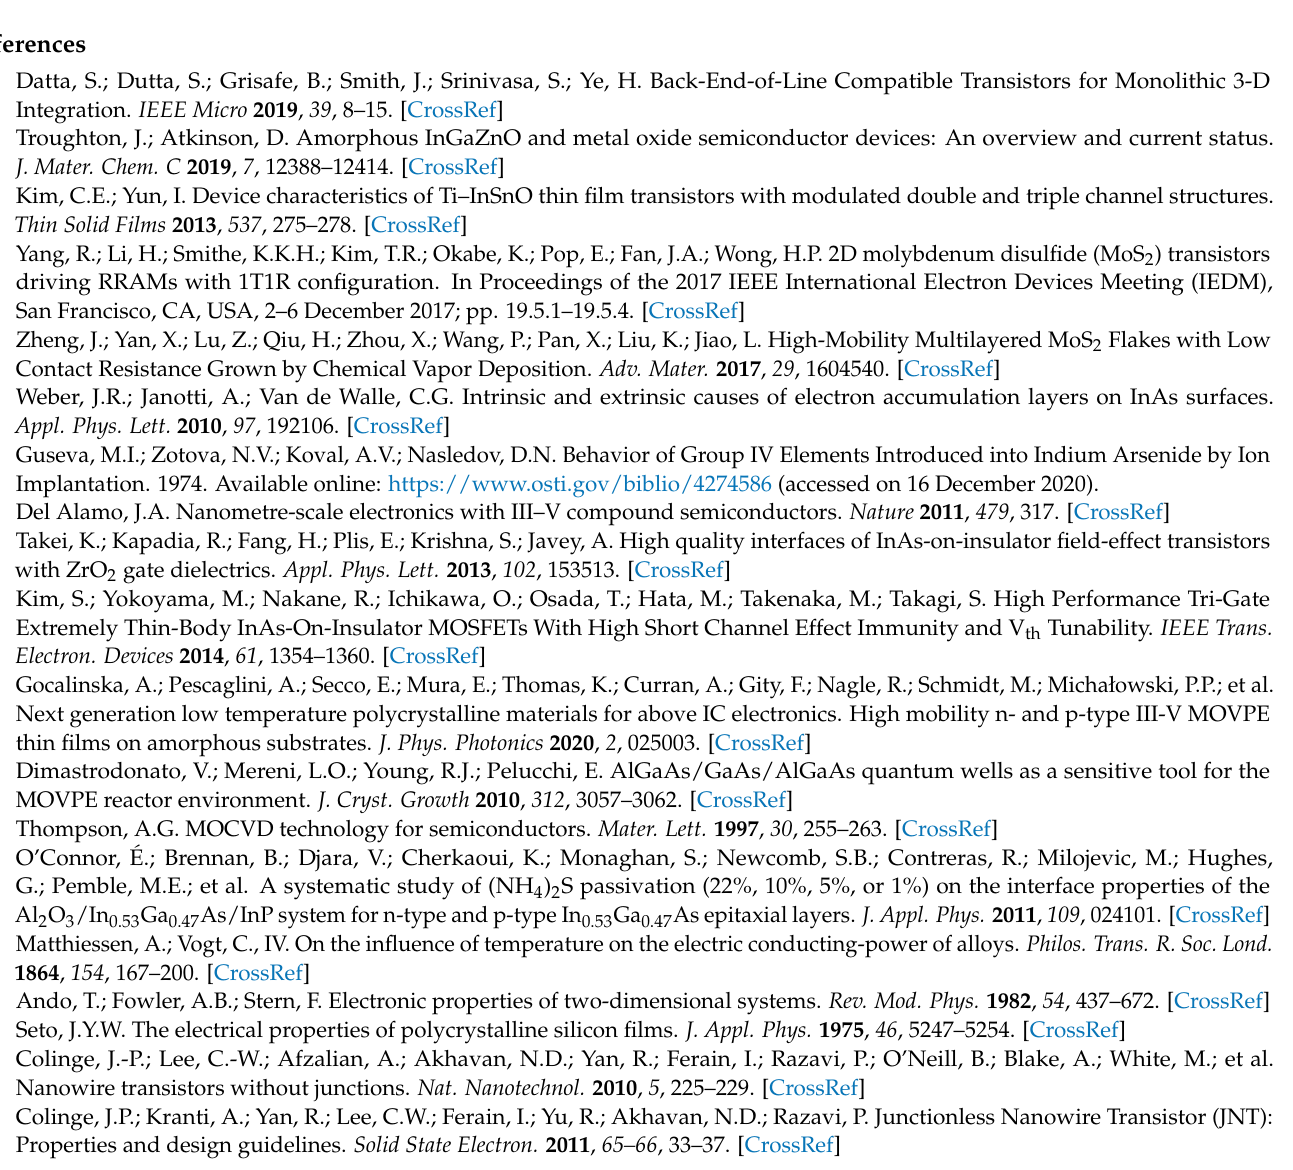
Figure S4: TOF-SIMS results showing level of (a) Ga, (b) In, and (c) As present vs. depth from surface, for sample consisting of nominally 25 nm poly GaAs buffer layer + 25 nm Zn-doped poly